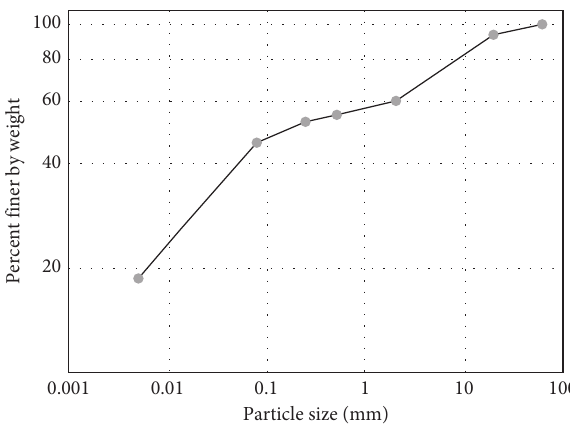
Figure 1: Particle size distribution of the tunnel muck. Table 1: XRF results of a typical fine muck sample with the particles size less than 2mm. Element